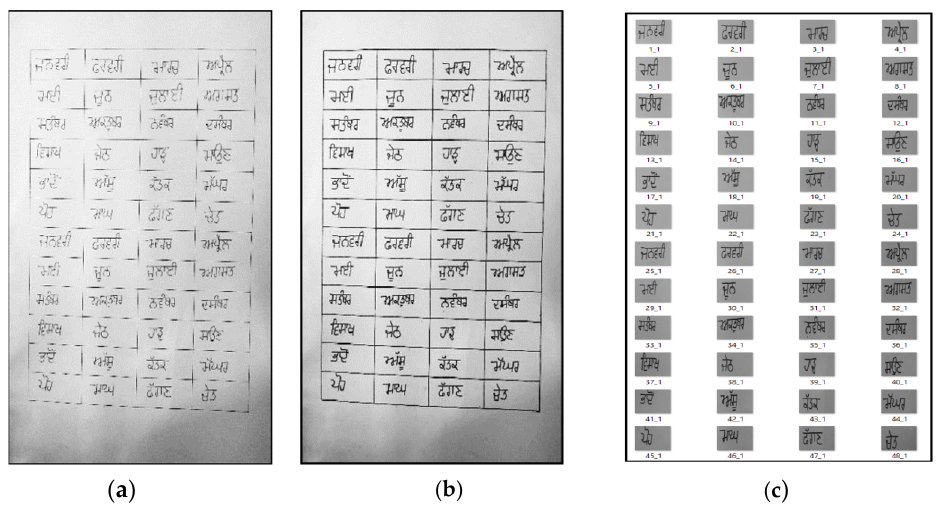
Figure 3. ( a ) Image converted from RGB to grayscale; ( b ) eroded image; ( c ) cropped images.